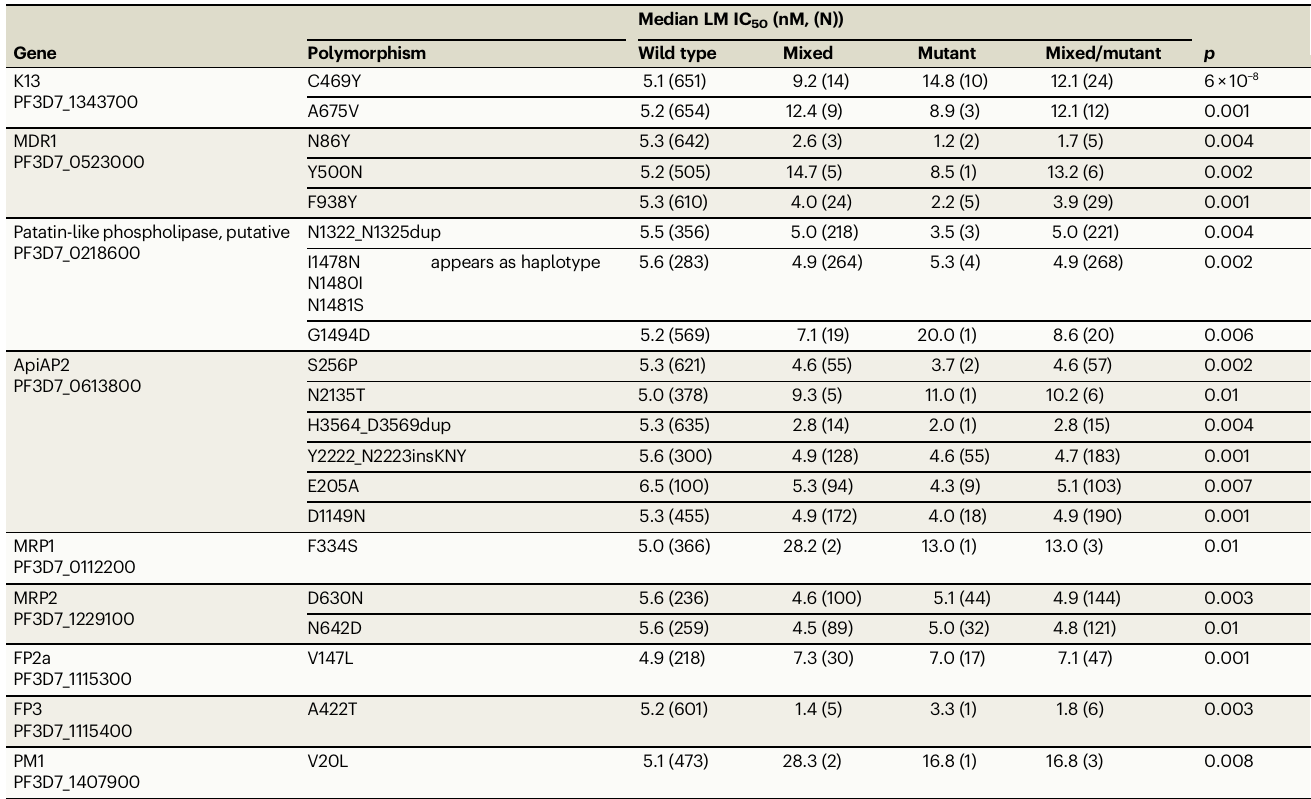
Table 4 | Polymorphisms associated with ex vivo lumefantrine